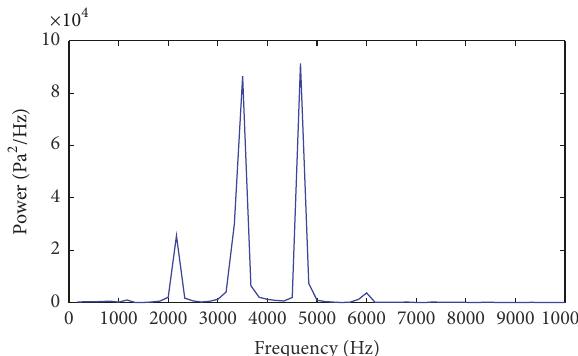
Figure 26: FFT of pressure for the control point (TC3).